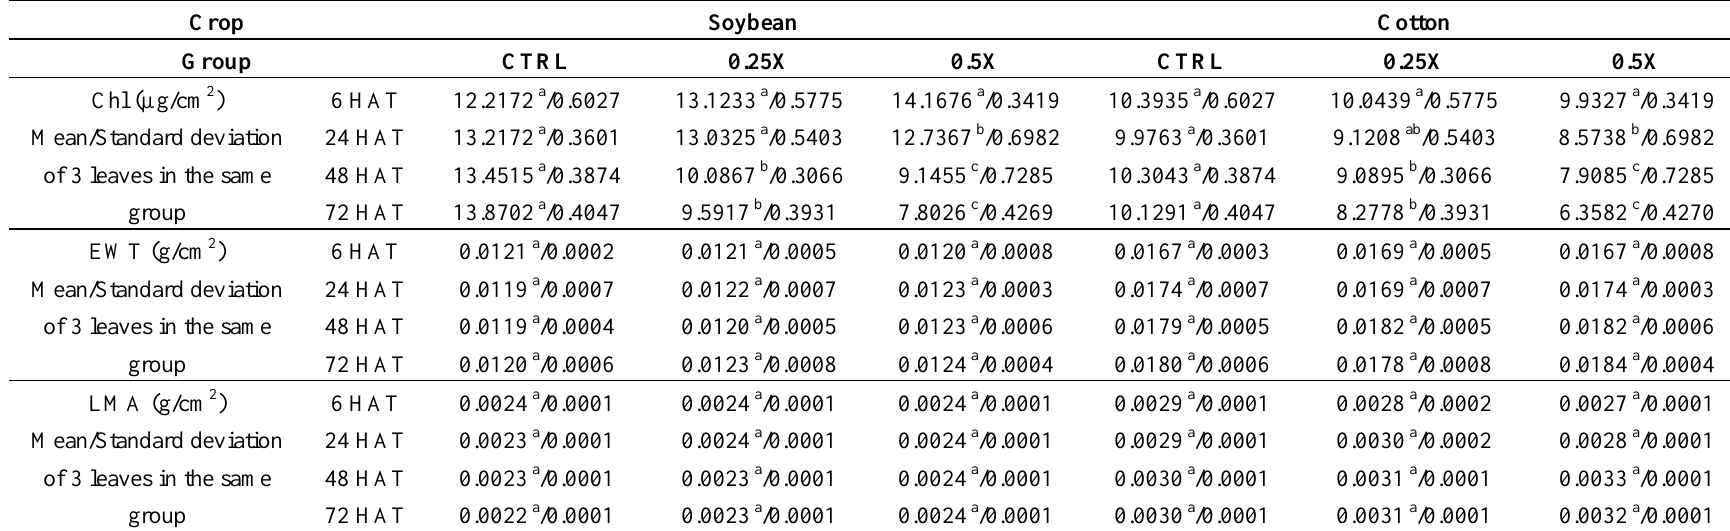
Table 1. Leaf biochemical measurements of soybean and cotton leaves acquired in the first experiment conducted on 17–20 December 2012. The mean values and standard deviations of the biochemical parameters (Chlorophyll content, Chl; Equivalent Water Thickness, EWT; Leaf Mass per Area, LMA) measured for each treatment group (CTRL group with no glyphosate treatment; 0.25X group treated with 0.217 kg·ae/ha solution of glyphosate; 0.5X group treated with 0.433 kg·ae/ha solution of glyphosate) at each time period after treatment (6, 24, 48, and 72 h After Treatment (HAT)) are shown in the table. The separation analysis of the mean values was conducted using Duncan’s multiple range test.